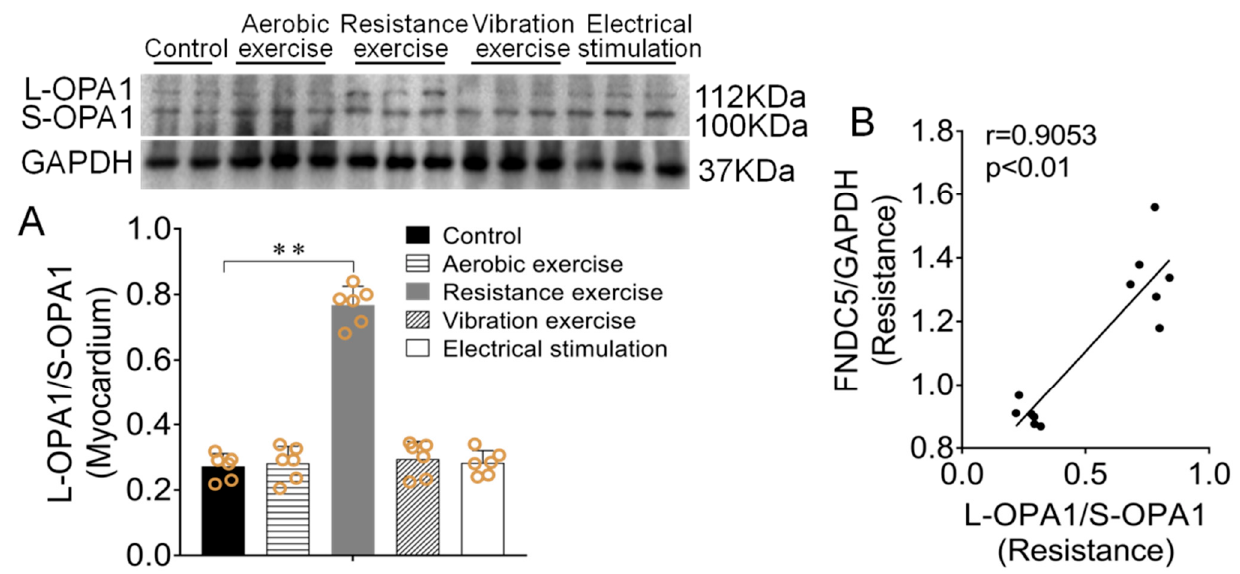
Figure 5. Effect of different types of exercise and skeletal muscle electrical stimulation intervention in mice myocardium OPA1 expression. ( A ) The effect of different types of exercise and skeletal muscle electrical stimulation intervention on mice’s myocardium L-OPA1/S-OPA1 ratio. ( B ) The Pearson correlation analysis between FNDC5 and OPA1 in myocardium after resistance exercise. Data are expressed as mean ± SEM ( n = 6). ** p < 0.01. Abbreviations: FNDC5: transmembrane protein fibronectin type III domain protein 5, OPA1: Optic atrophy protein-1.